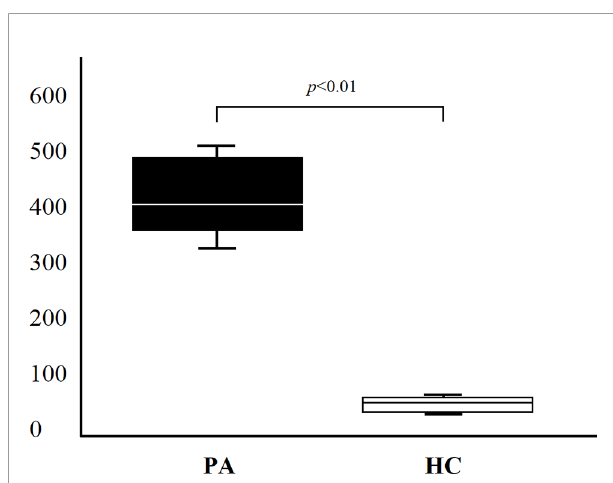
FIGURE 3 | IL-19 production (pg/ml) of lamina propria mononuclear cells obtained from gastric specimens of 8 PA patients and 4 HC. Comparison of gastric IL-19 (mean ± SD) production between PA patients and